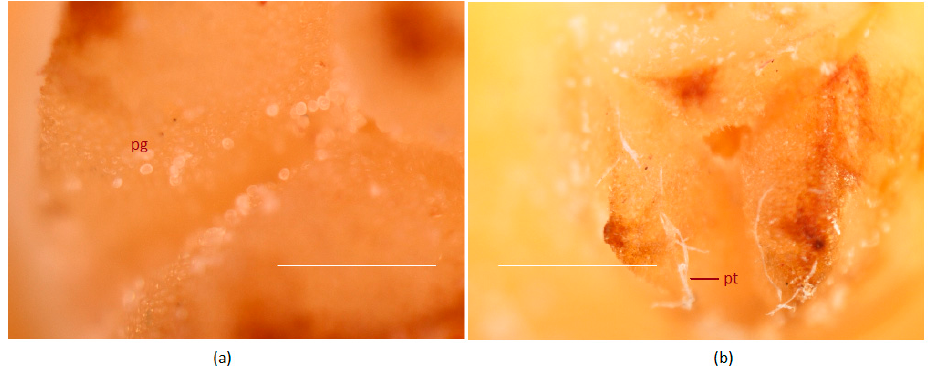
Figure 4. In planta pollen grain germination of the coconut variety WCT on the receptive stigma surface after pollination. ( a ) Ungerminated pollen grains 4 h after pollination and ( b ) germinated pollen grains with pollen tubes 24 h after pollination. Pollen tubes are marked by an arrow (pt); pg, pollen grains. Stigma surface was stained with quadruple stain [59] and visualized using a stereo microscope. Scale bar = 100 μ m.